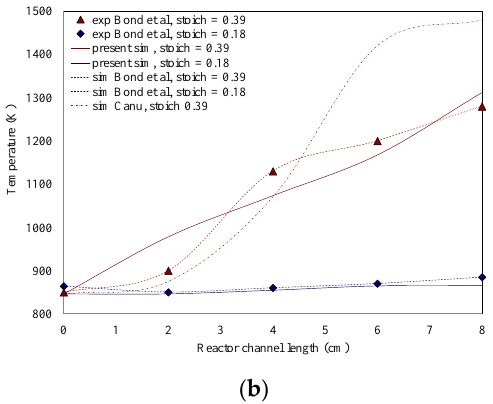
Figure 1. Experimental data by Bond et al. [31] and comparison with numerical data by Bond et al. [31] and Canu [32] at low and high inlet stoichiometry for ( a ) methane conversion and ( b ) temperature distributions.